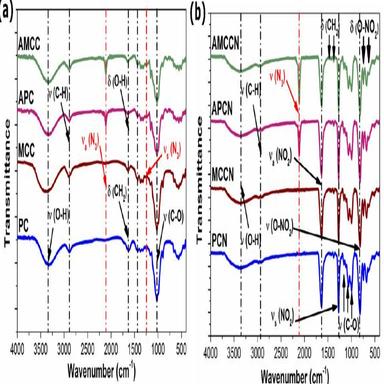
IR spectra of (a) functionalized samples and their starting precursors; (b) nitrated samples.